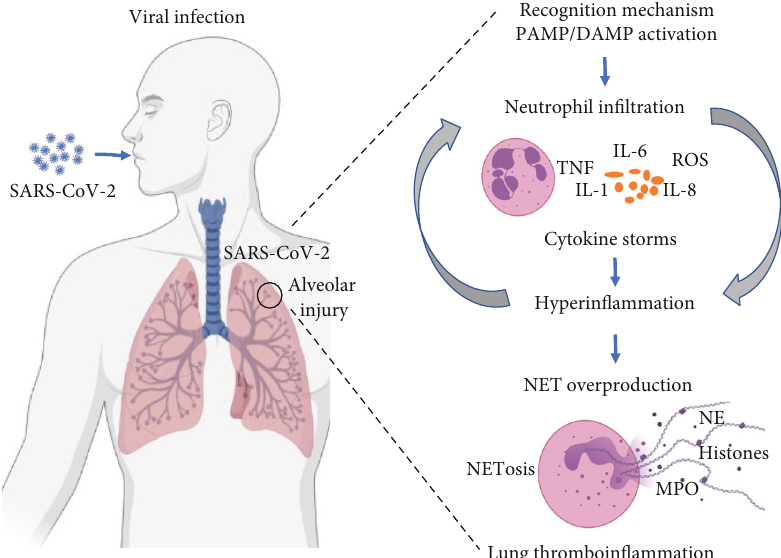
Figure 1: The interaction hypothesis between neutrophil and hyperin fl ammation in COVID-19. After the host-viral interaction, the virus signaling leads to a cascade of interactions between the virus recognition mechanism, neutrophil activation, and in fl ammatory stimuli. The NETosis process can protect the host during the virus response or exacerbate lung hyperin fl ammation in COVID-19 patients. The fi gure is made with BioRender (https://app.biorender.com/). Abbreviations: SARS-CoV-2: severe acute respiratory syndrome coronavirus 2; PAMP: pathogen-associated molecular pattern; DAMP: danger-associated molecular pattern; TNF: tumor necrosis factor; IL-6: interleukin-6; IL-1: interleukin-1; IL-8: interleukin-8; ROS: reactive oxygen species; NE: neutrophil elastase; MPO: